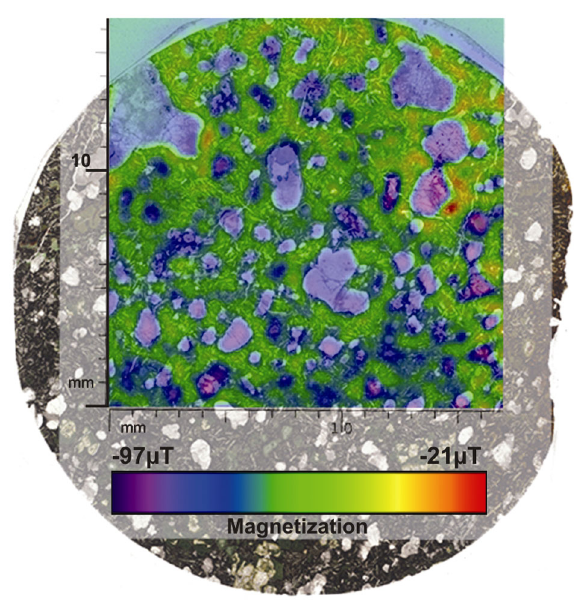
Fig. 5. Example of the optical image of the thin section with the magnetic scan displaying magnetization over the surface of the